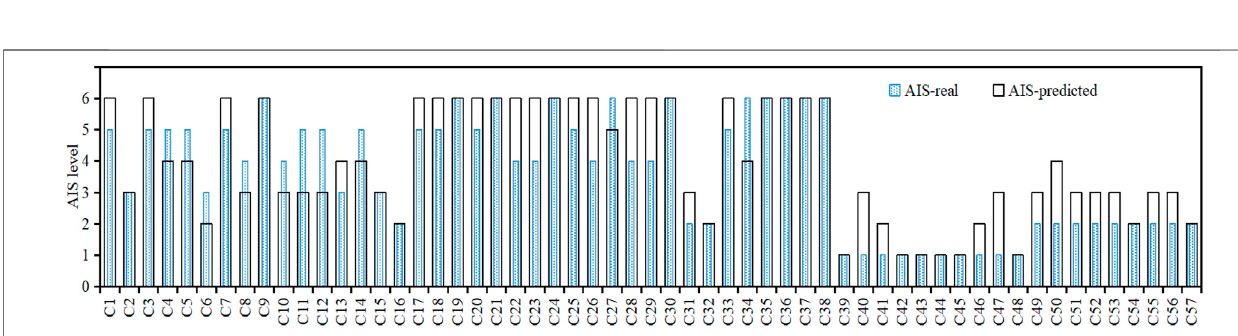
FIGURE 4 | Comparison of pedestrian contact location (A) and fi nal position (B) between reconstructions and real-world cases.